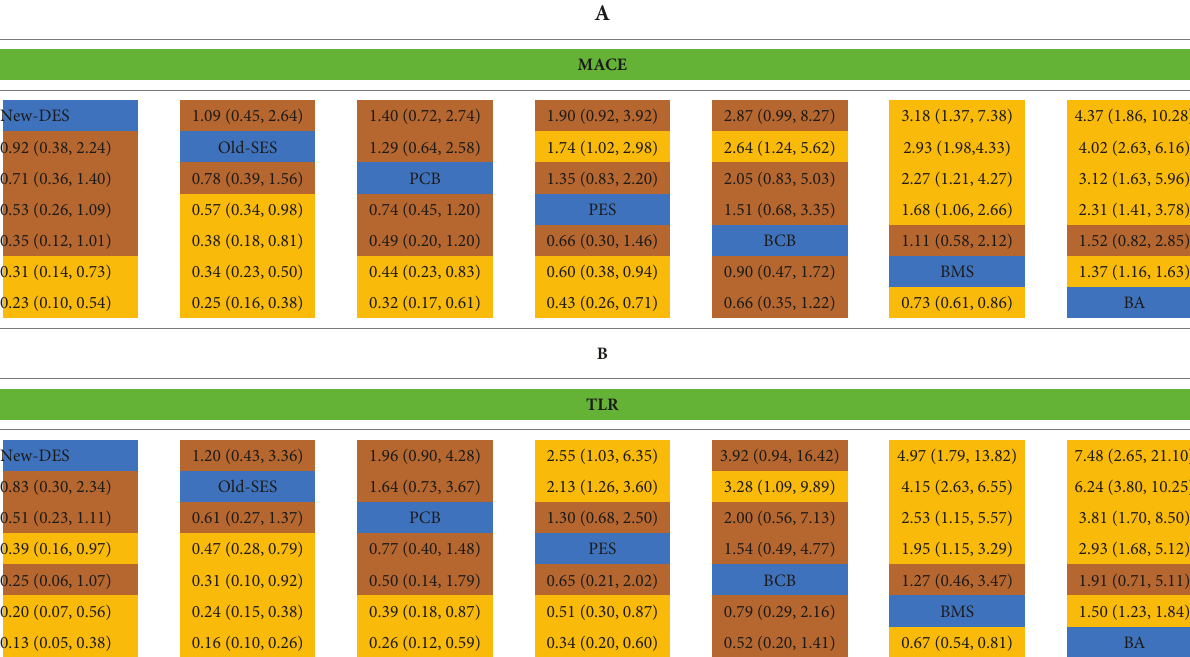
TABLE 2 The primary network meta-analysis estimates of MACE and